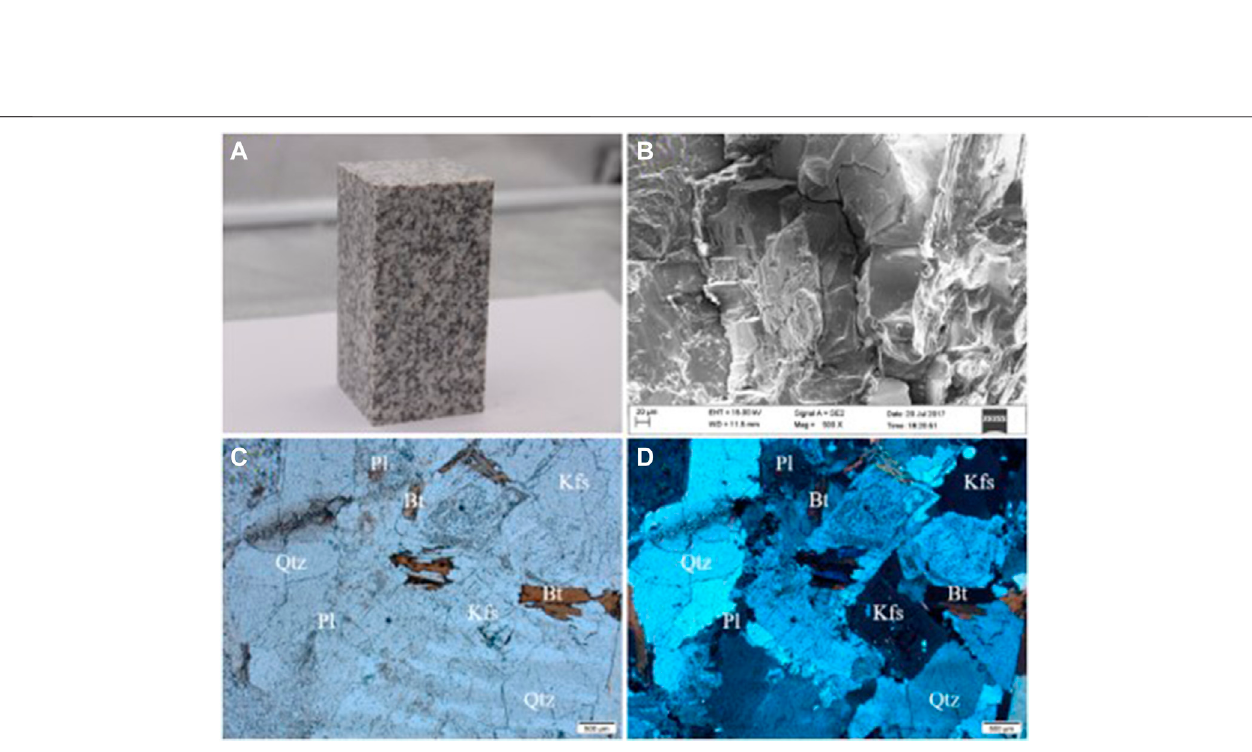
Frontiers in Earth Science |